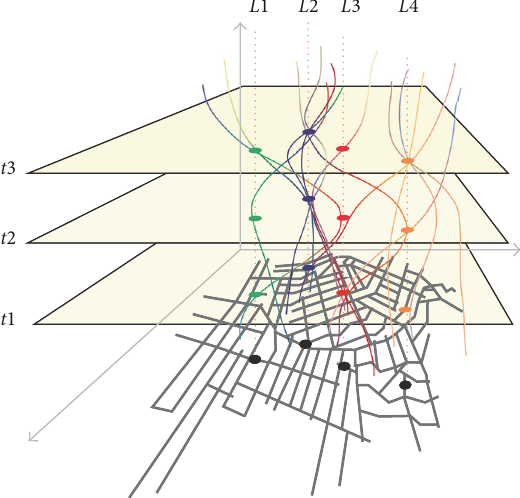
associated with our actions in architectural and urban spaces.